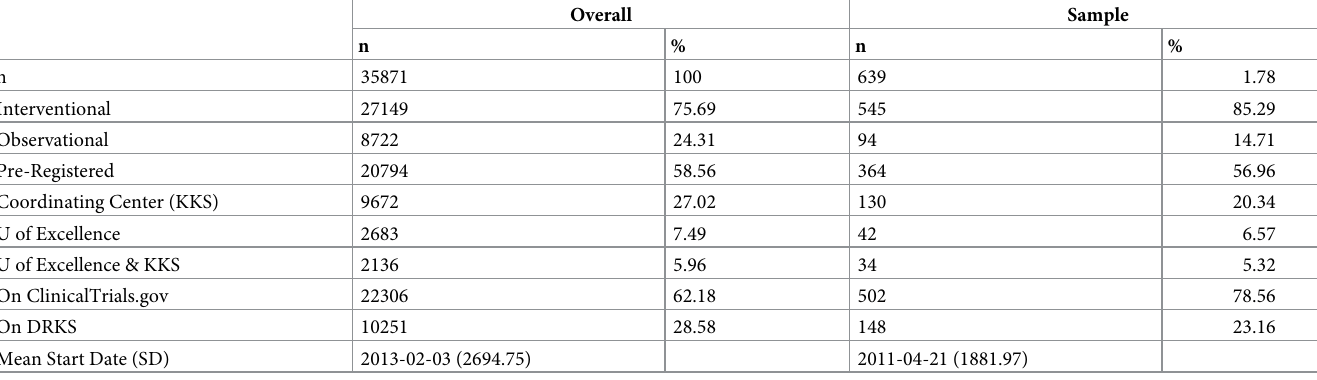
Table 2. General descriptive information of the overall database and the manually inspected sample.